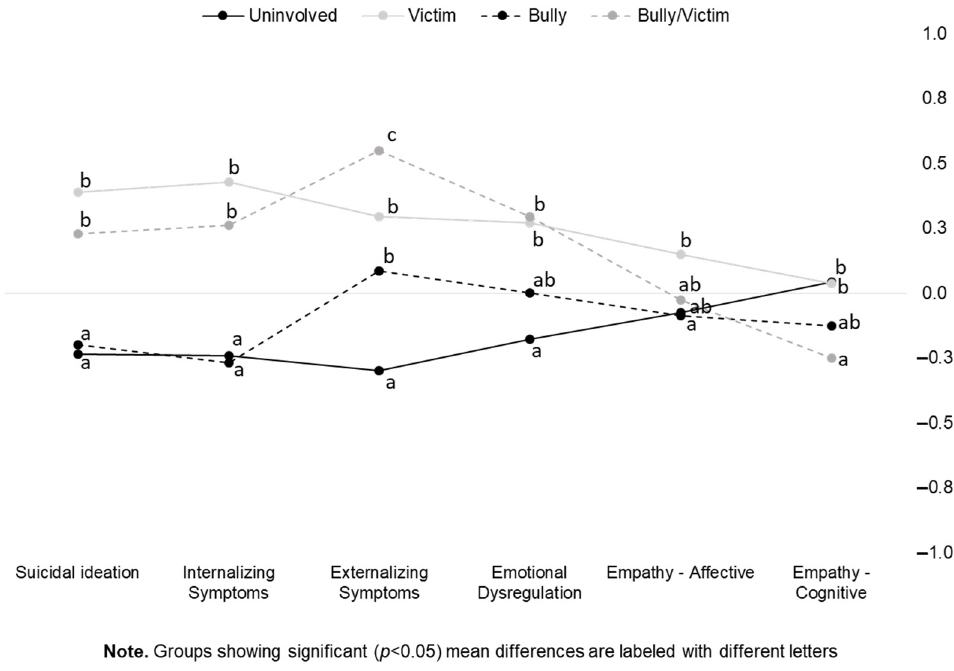
Figure 1. Multivariate profile of psychological distress and empathy by a bullying role in cyberbullying episodes.